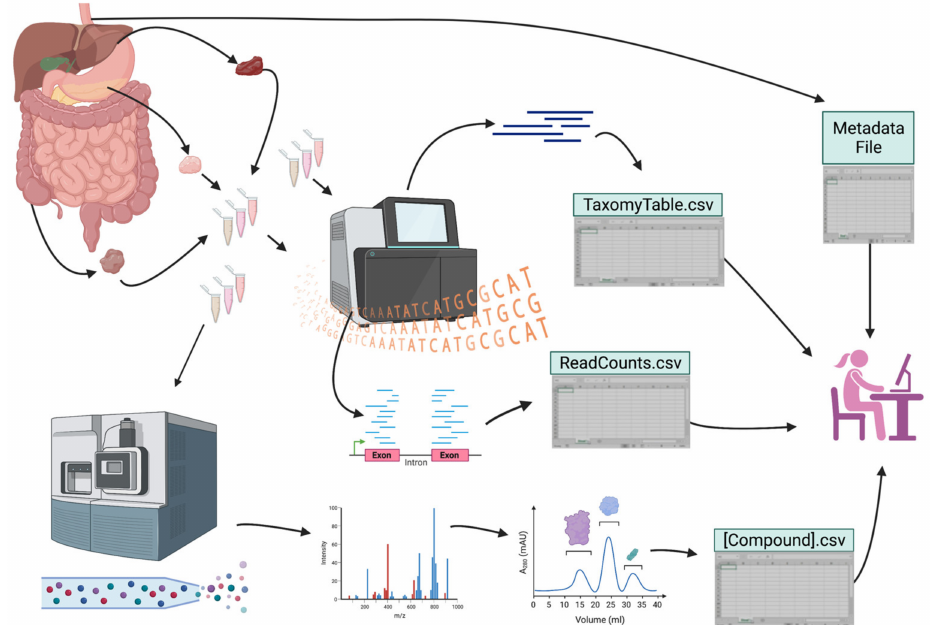
Figure 1. A pipeline for multi-omics data generation and analysis. Luminal GI, hepatobiliary, and pancreatic tissue can be sampled, homogenized, and used to generate multiple types of data from the same sample, such as DNA and RNA sequencing, as well as metabolomic and proteomic mass spectrometry-based and NMR-based data. These data can then be quality checked, cleaned, and processed into final datasets which can then be incorporated into a set of integrative analyses.